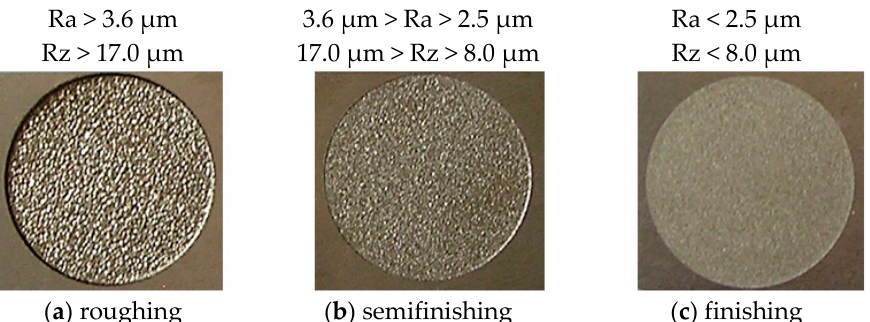
Figure 3. Eroded areas of experimental samples from tool steel EN X32CrMoV12 ‐ 28 after die ‐ sinking EDM roughing, semifinishing, and finishing with SF ‐ Cu electrode.